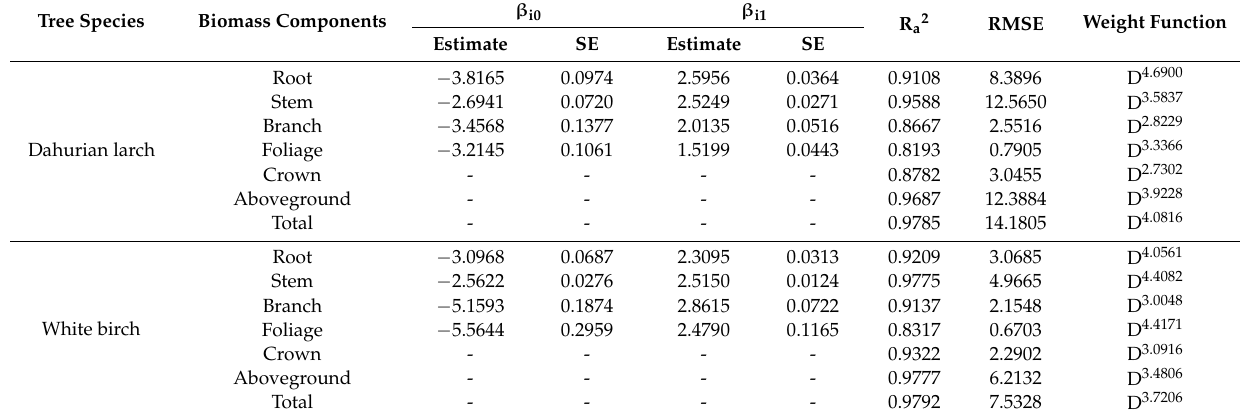
Table 5. Model coefficient estimates, standard errors, goodness-of-fit statistics, and weight functions for the additive system of biomass equations based on one predictor (D only, namely